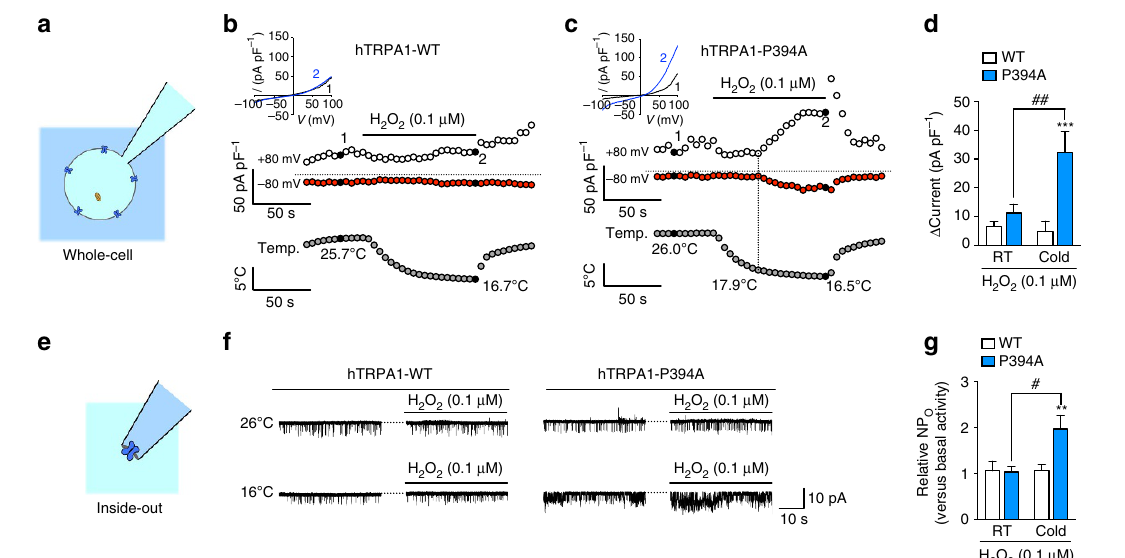
Figure 1 | Hydroxylation-susceptible Pro 394 in hTRPA1 is responsible for cold sensitivity in the presence of H 2 O 2 . Either hTRPA1-WT- or hTRPA1- P394A-expressing cells were exposed to cold in the presence or absence of 0.1 m M H 2 O 2 and analysed by whole-cell ( a – d ) or inside-out patch-clamp recordings ( e – g ). ( a – d ) Schematic diagram of a whole-cell patch-clamp configuration ( a ) along with representative whole-cell recordings from a hTRPA1- WT- ( b ) and a hTRPA1-P394A-expressing cell ( c ), and the statistical analysis ( d , n ¼ 7–8). Membrane potential was 0mV. Insets in b and c are current– voltage relationships at the time indicated by black-filled circles. *** P o 0.001 versus hTRPA1-WTunder the same condition; ## P o 0.01; two-way ANOVA with Sidak’s post hoc test. ( e – g ) Schematic diagram of an inside-out patch-clamp configuration ( e ) along with representative single-channel currents of similar inside-out patches from a hTRPA1-WT- or hTRPA1-P394A-expressing cell in the presence or absence of 0.1 m M H 2 O 2 at 26 (cid:2) C (upper panels) or 16 (cid:2) C (lower panels) ( f ), and a statistical analysis of the relative open probability (NP O ) compared with the basal NP O in RTor cold conditions ( g , n ¼ 13–14). Membrane potential was (cid:2) 60mV. ** P o 0.01 versus hTRPA1-WTunder the same condition; # P o 0.05; two-way ANOVA with Sidak’s post hoc test. All data are expressed as mean ± s.e.m. A detailed analysis of the inside-out patches is shown in Table 1. RT, room temperature. Table 1 | Parameters of hTRPA1-WT and hTRPA1-P394A activity in the cold and/or H 2 O 2 stimulation. 26 (cid:2) C 16 (cid:2) C Basal hTRPA1-WT Conductance (pS)